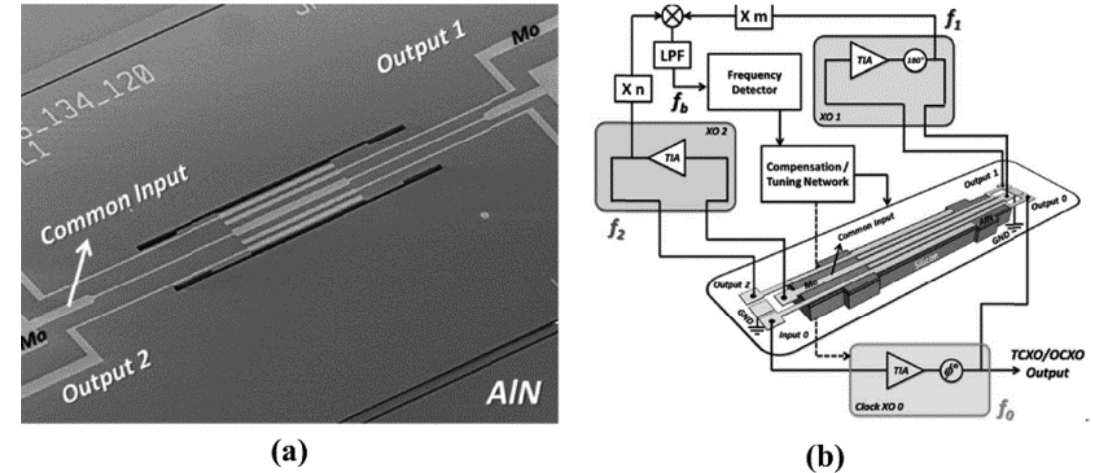
Figure 21. ( a ) SEM image; and ( b ) Schematic block diagram of a reference oscillator for Q-UCRB sensor for temperature sensing. Reproduced with permission from [109]. Copyright © 2013, IEEE.